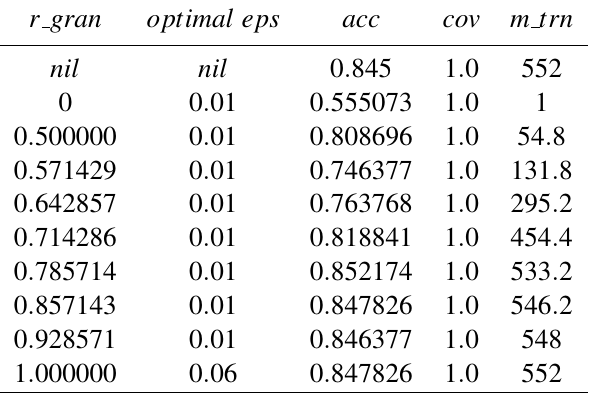
CV-5; Australian credit; Algorithm 6 v3. r gran=granulation radius, optimal eps= optimal epsilon, acc= accuracy, cov= coverage, m trn=mean training set